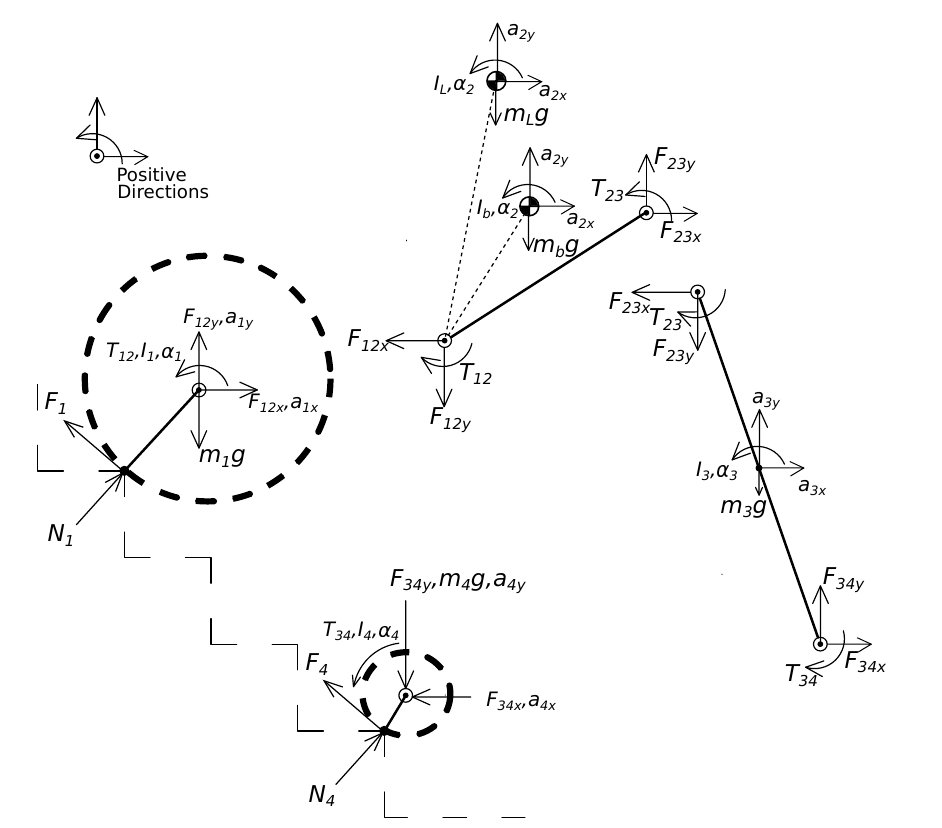
Figure 7. Free body diagram of the members of